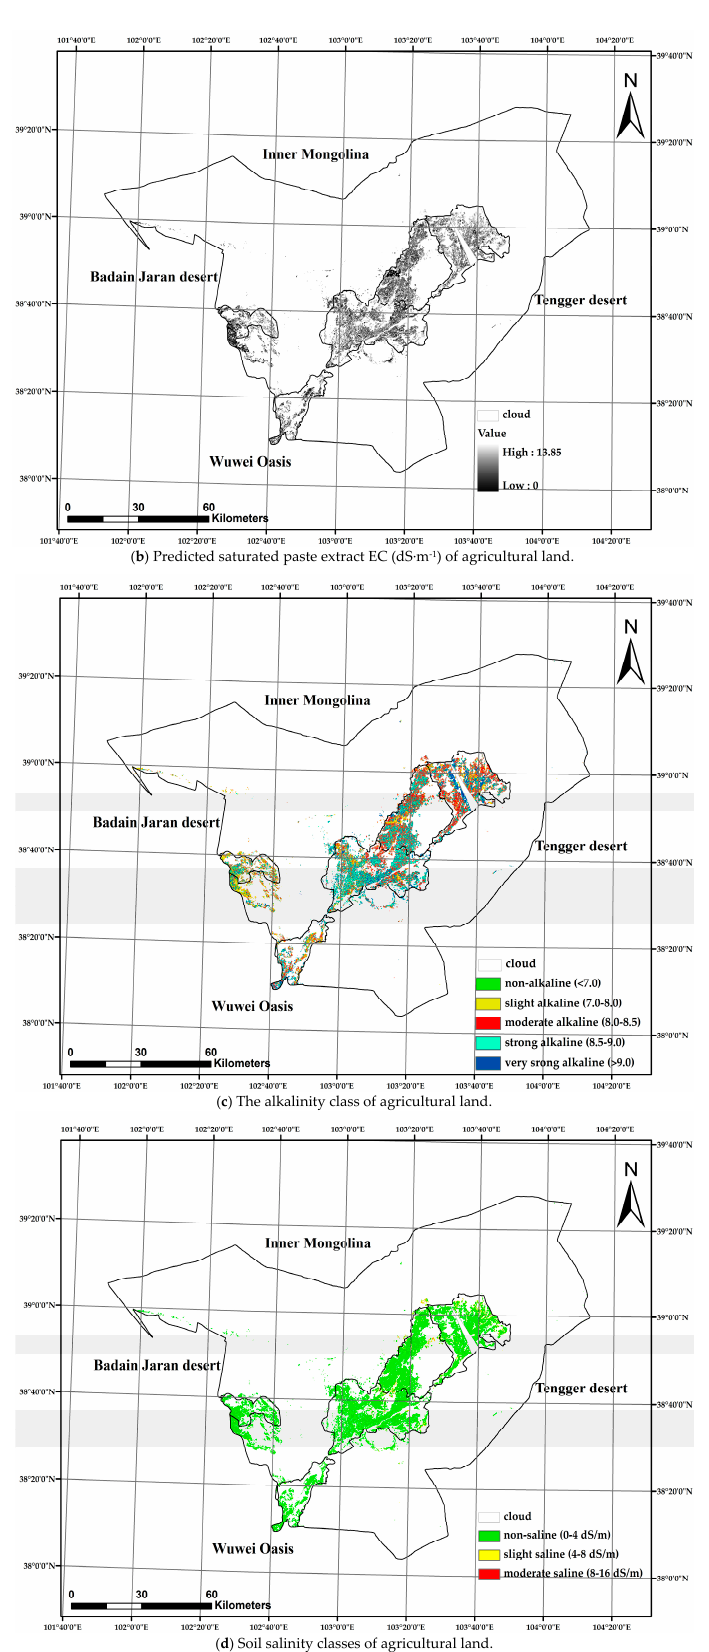
Figure 6. pH and EC maps ( a , b ) estimated by the optimal ANN models applied to the agricultural land of study area, and their respective classes ( c , d ).